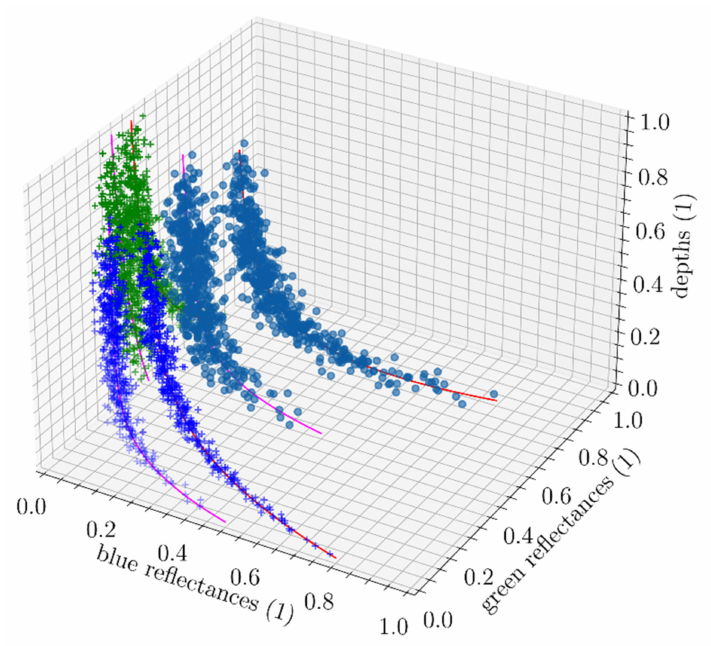
Figure 23. Example of a cloud of depth-green-blue samples and a trained multispectral BNP mixture. The cloud of samples (in faded blue) consist of two distinguishable sub-cloud. Green points are the projection of those samples unto depth-blue plane, Blue points are the projection unto depth-green plane. Those projection planes are analogous to scatter plots exhibited in previous